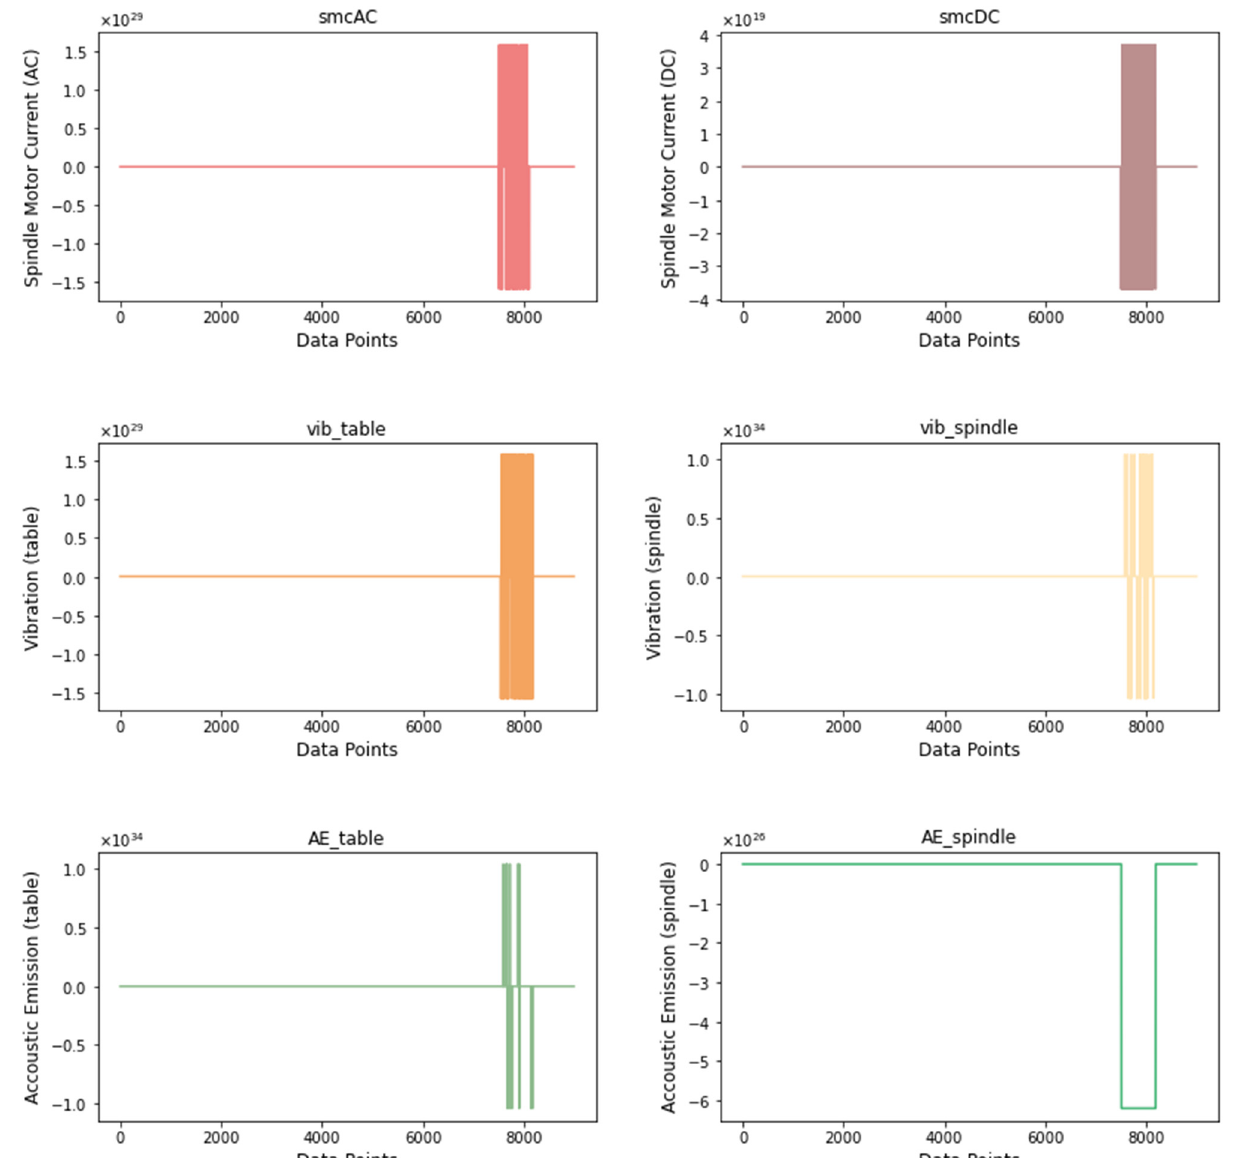
Figure 4. Signatures from the six sensors showing an outlier for case 2, run 1.